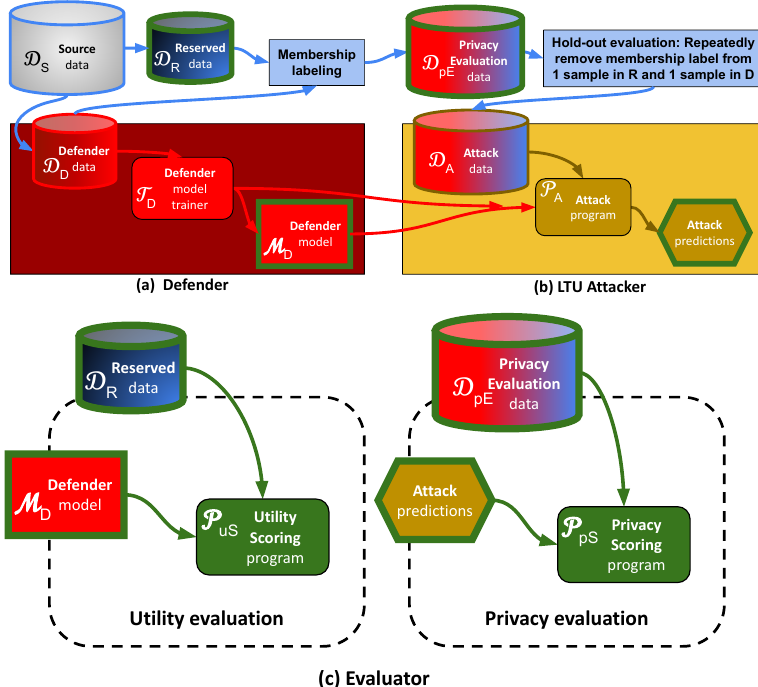
Figure 1. Methodology flow chart. ( a ) Defender: Source data are divided into Defender data, to train the model under attack (Defender model) and Reserved data to evaluate such a model. The Defender model trainer creates a model optimizing a utility objective, while being as resilient as possible to attacks. ( b ) LTU Attacker: The evaluation apparatus includes an LTU Attacker and an Evaluator: The evaluation apparatus performs a hold-out evaluation leaving two unlabeled examples (LTU) by repeatedly providing the LTU Attacker with ALL of the Defender and Reserved data samples, together with their membership origin , hiding only the membership label of 2 samples. The LTU Attacker must turn in the membership label (Defender data or Reserved data) of these 2 samples (Attack predictions). ( c ) Evaluator: The Evaluator computes two scores: LTU Attacker prediction error (Privacy metric), and Defender model classification performance (Utility